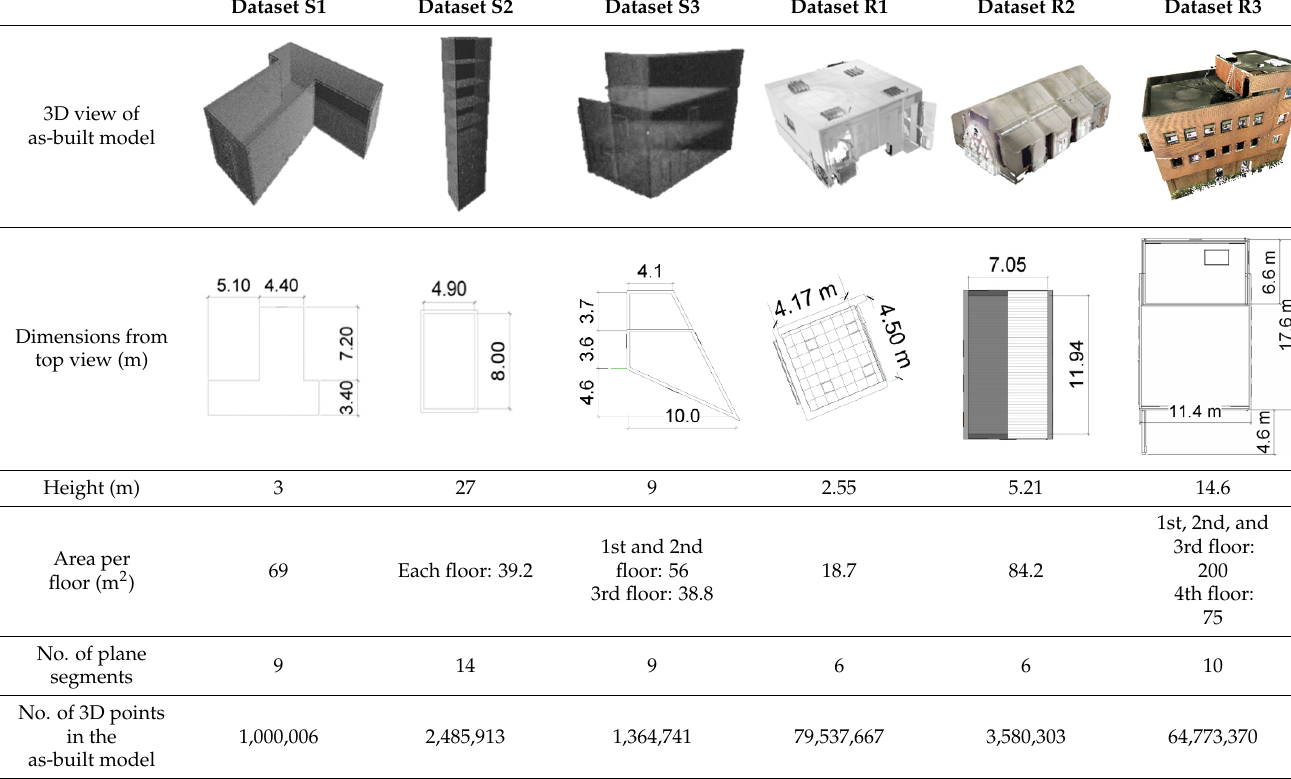
Table 1. Details of stimulated datasets. Table 1. Details of stimulated datasets . Table 1. Details of stimulated datasets . Table 1. Details of stimulated datasets . Table 1. Details of stimulated datasets . Table 1. Details of stimulated datasets . Table 1. Details of stimulated datasets . Table 1. Details of stimulated datasets . Table 1. Details of stimulated datasets . Table 1. Details of stimulated datasets . Table 1. Details of stimulated datasets . Table 1. Details of stimulated datasets . Table 1. Details of stimulated datasets